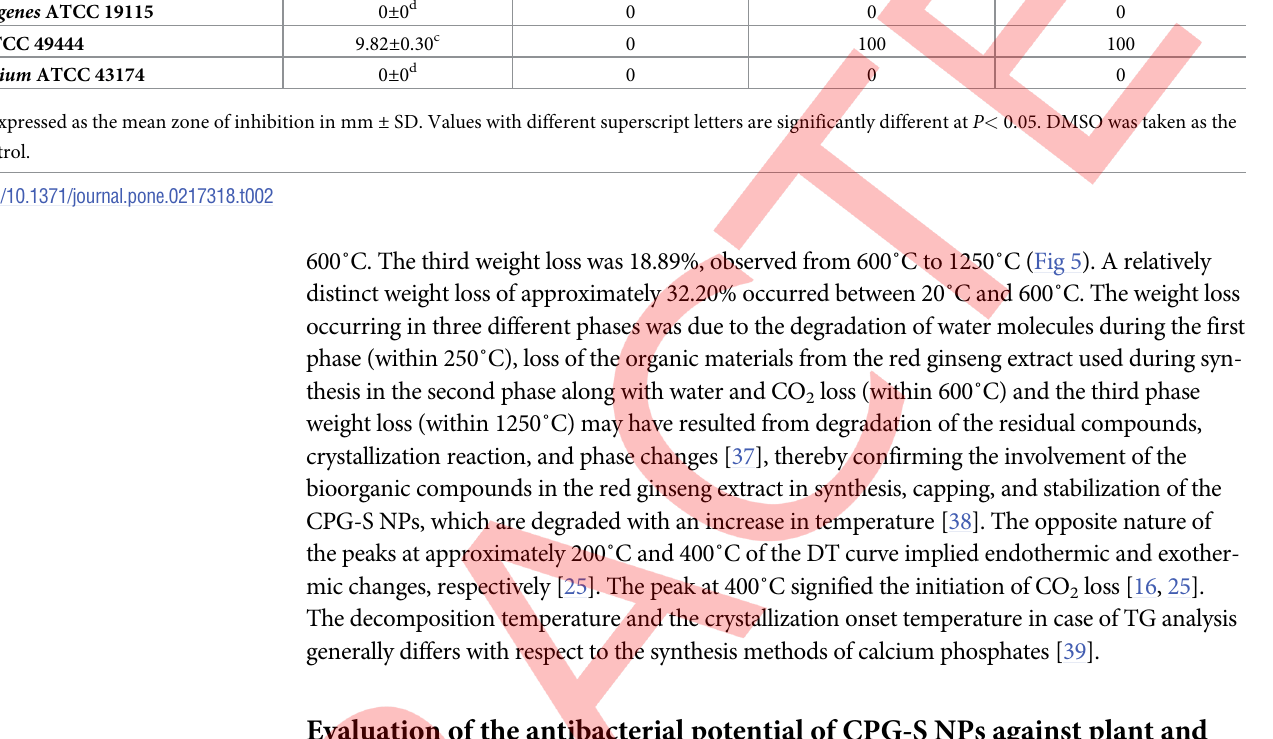
Table 2. Antibacterial activity of calcium phosphate nanoparticles synthesized using ginseng extract and conjugated with streptomycin against foodborne patho- genic bacteria. Foodborne pathogenic bacteria